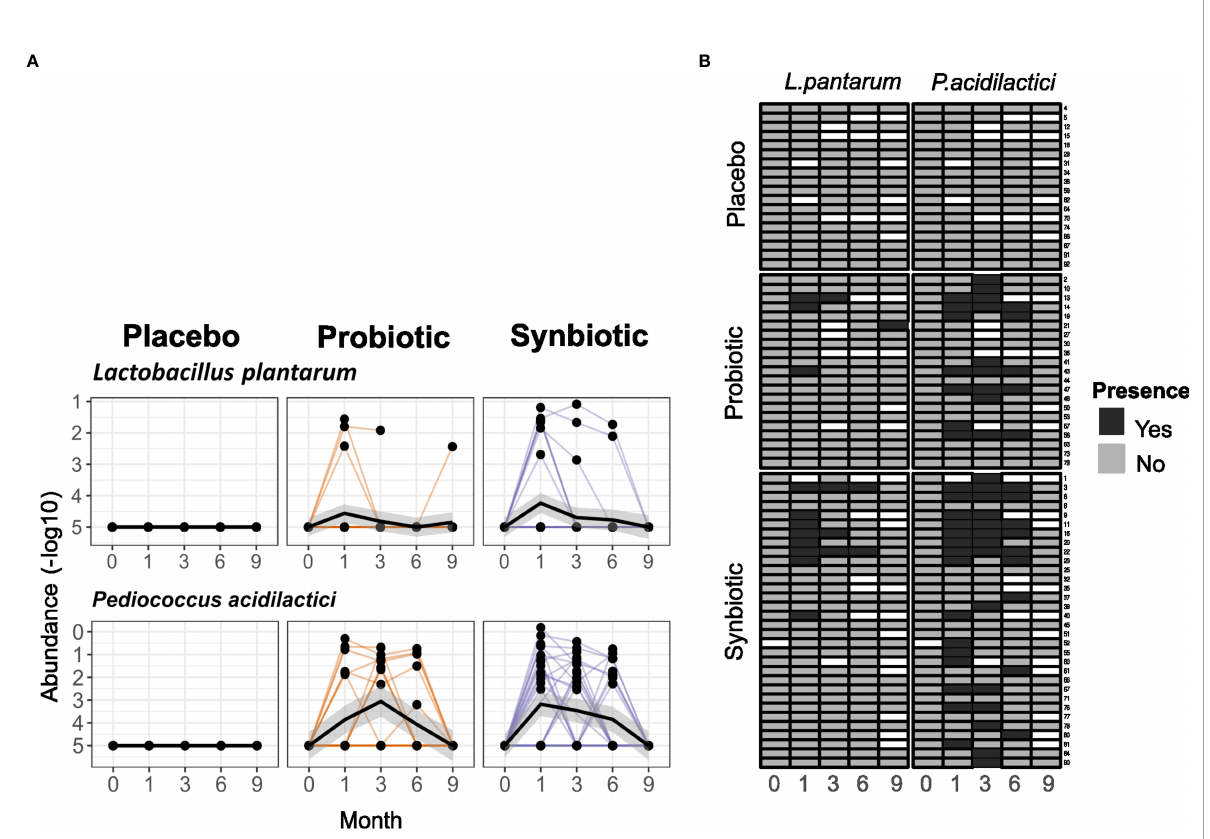
FIGURE 5 Detection of the probiotic strains in stool samples. (A) Relative abundances (in -log10) of P. acidilactici and L. plantarum in faeces for each of the intervention arms. (B) Heatmap representing presence/absence of each arm in each sample. Rows represent single patients and columns represent the month each sample belongs to. White cells represent lack of